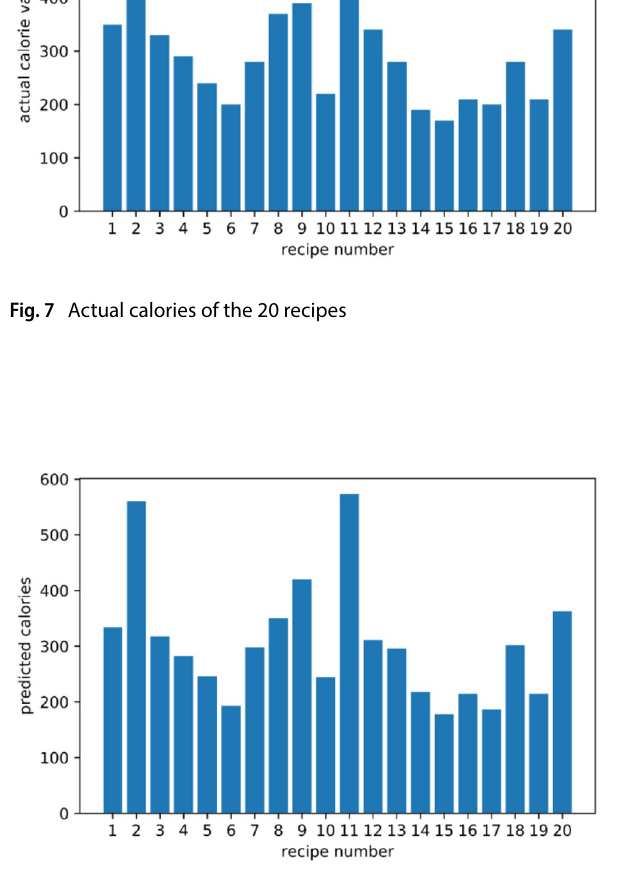
Fig. 8 Predicted calorie content of the 20 recipes